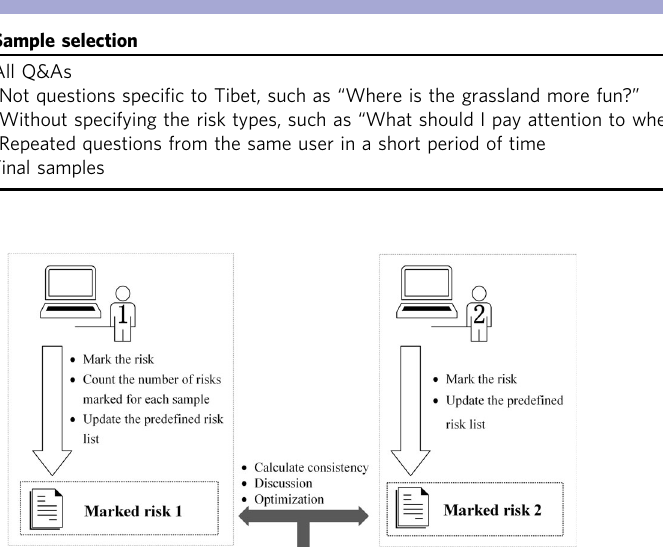
Table 1 Pretravel sample selection process.